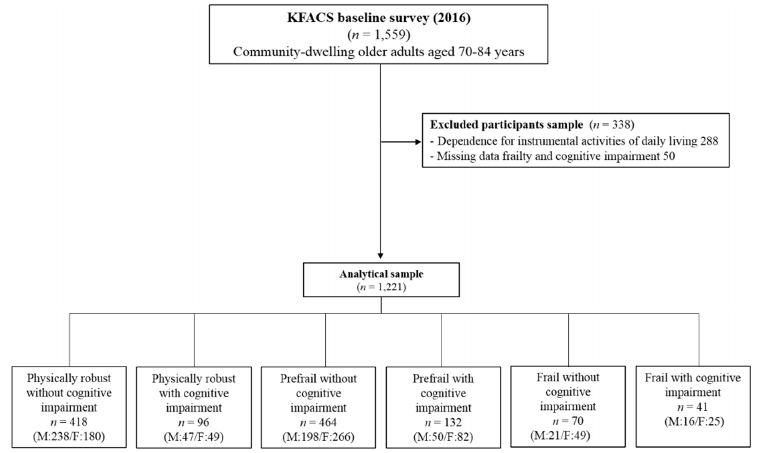
Figure 1. Flow chart of study participant selection.